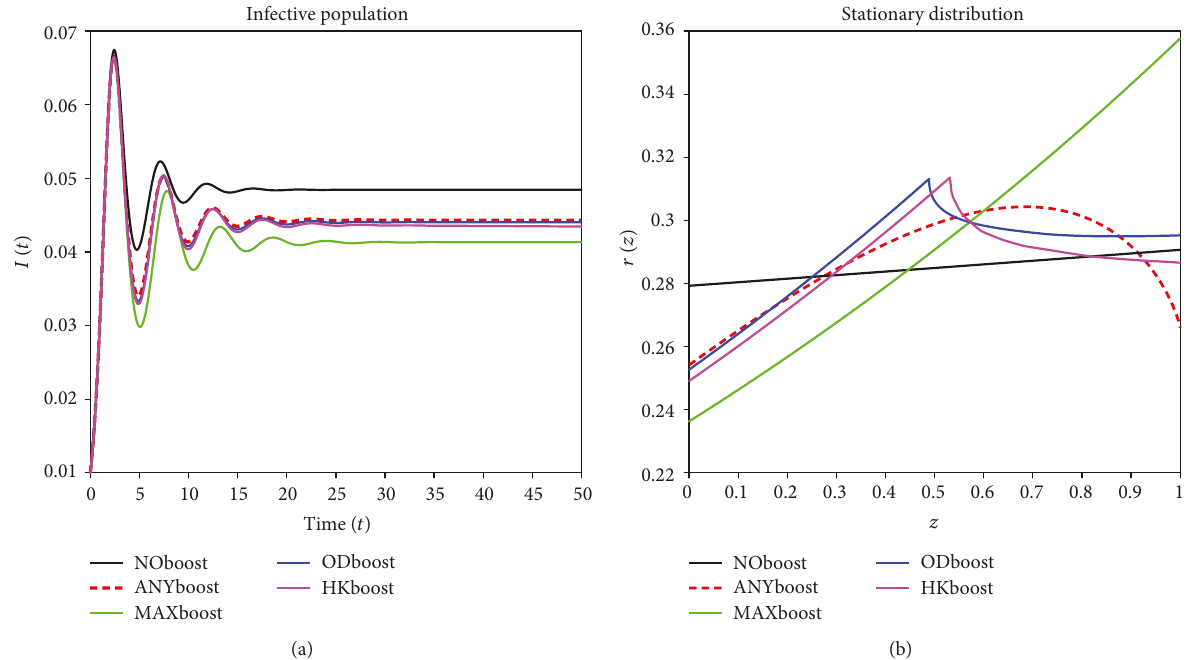
Figure 4: Comparison of di ff erent boosting mechanisms in case of a stable endemic equilibrium. (a) The infective population in case of NOboost (black curve), MAXboost (green), ANYboost (red dotted), ODboost (blue), and HKboost (magenta). (b) The stationary distribution in the immune population r z corresponding to